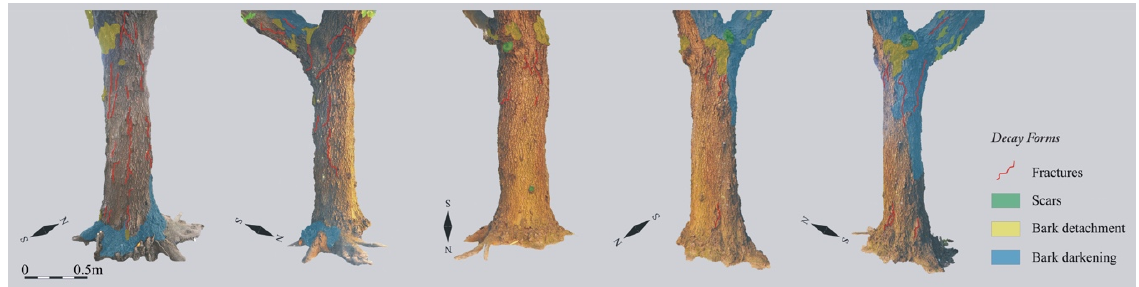
Figure 7. CRP 3D model of the studied living holm oak and shallow decay forms (2018 survey).